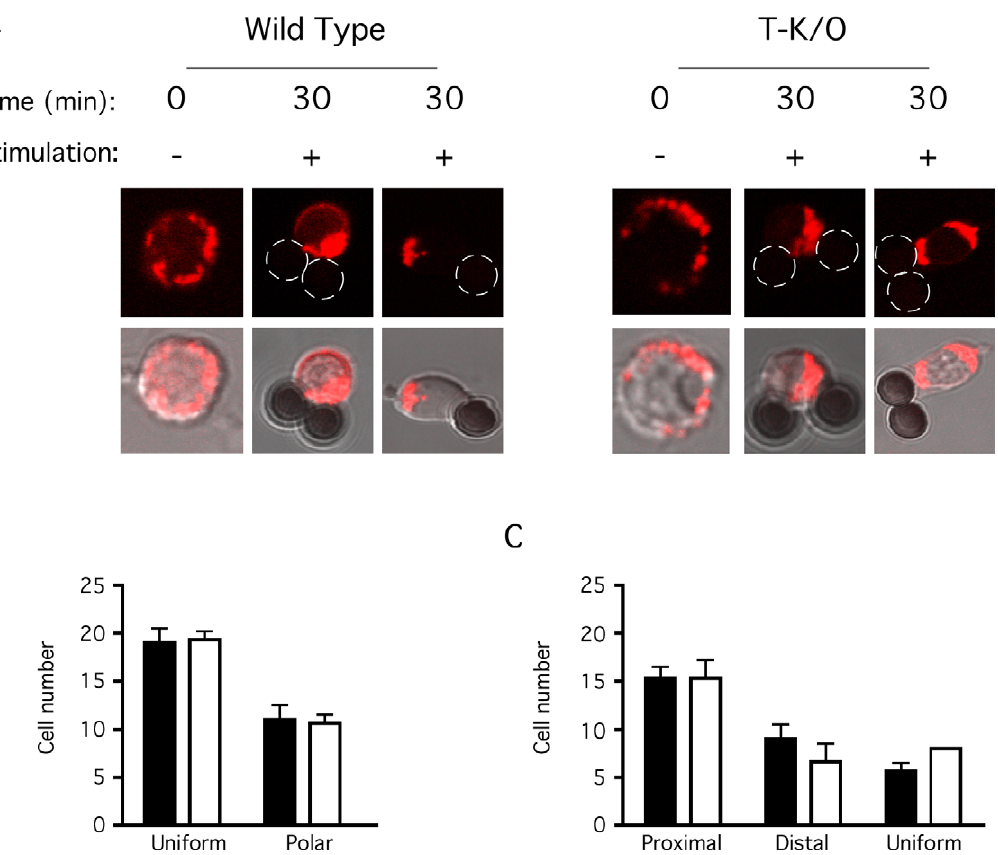
Figure 6. SLP-2-deficient T cells show normal mitochondrial recruitment upon T cell stimulation. T cells were isolated from wild type and SLP-2 T-K/O (T-K/O) mice and stained with MitoTracker Red. Stained cells were plated on poly-L-lysine coated confocal dishes and incubated for 10 minutes to promote adherence. Cells were stimulated for 30 minutes with anti-CD3 and anti-CD28 antibody coated beads or left unstimulated. Cells were then fixed and imaged by confocal microscopy. These images are representative of at least 100 individual cells, imaged in three independent experiments. A) Representative confocal images are shown for wild type and SLP-2-deficient T cells in the absence (0 min) and presence (30 min) of T cell stimulation (2 different cells for each). Mitochondria are shown in red and stimulating beads can be seen in the light image overlay. B) The location of the mitochondria was quantified in un-stimulated wild type (black bars) and SLP-2-deficient (white bars) T cells was quantified as either a polar distribution with mitochondria being clustered together at one end of the cell or a uniform distribution, with mitochondria located throughout the entire cell. C) The location of the mitochondria in stimulated wild type and SLP-2-deficient T cells was quantified as proximal to the stimulating bead, distal to the bead or uniformly distributed throughout the cytoplasm, in a manner similar to that in figure 4. These plots represent an average of 3 independent experiments, in which 30 cells for each group were counted.